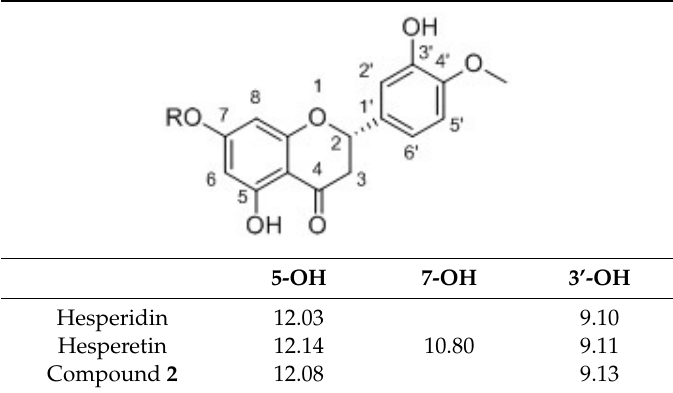
Table 1. 1 H-NMR data of the compounds’ OH groups ( δ in ppm).